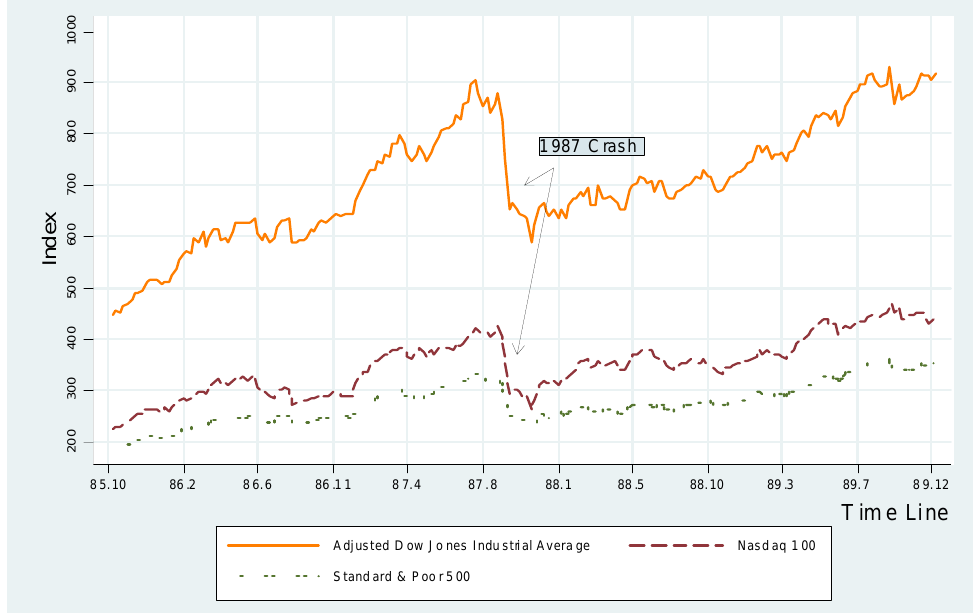
Figure 1: Three Major U.S. Stock Indices (1985 -